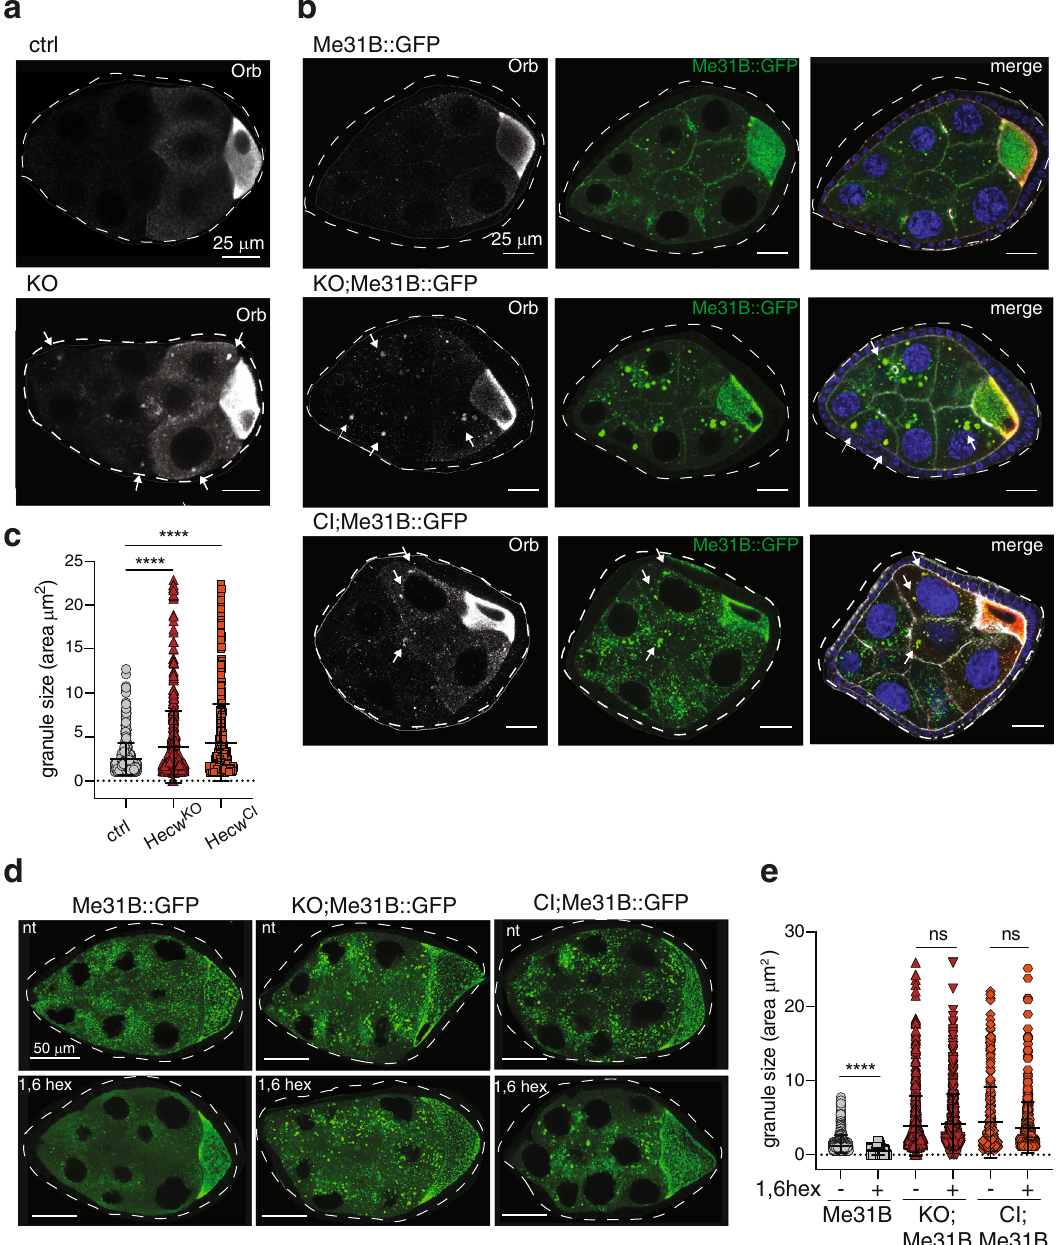
Fig. 4 RNP morphology and composition is altered in Hecw KO . a IF analysis of egg chambers from 3-day-old fl ies of the indicated genotypes with anti-Orb antibody ( n = 3). White arrows indicate ectopic Orb puncta in nurse cells of Hecw KO fl ies. b IF analysis of the indicated genotypes ( n = 3). Green, Me31B::GFP which marks the RNPs; red, Orb which marks the oocyte (in white in the fi rst panel); blue, DAPI; white, phalloidin. Scale bar: 25 μ m. c Quanti fi cation of RNPs size of egg chambers (stages from 6 – 9) from 3-day-old fl ies of the indicated genotypes. Results are expressed as mean ± SD. n = 477 (ctrl Me31B::GFP), n = 559 (Hecw KO ;;Me31B::GFP), n = 444 (Hecw CI ;;Me31B::GFP), 5 egg chambers/genotype from two biological replicates. **** P < 0,0001 by two-tailed Mann – Whitney test. d IF analysis of egg chambers of 3-day-old fl ies as indicated ( n = 3), not treated (nt) or treated with 1,6 hexanediol (1,6 hex). Scale bar: 50 μ m. e Quanti fi cation of RNPs size in egg chambers (stage 7 – 9) of the indicated genotypes and conditions. Treatment signi fi cantly reduces RNP size in control but not in Hecw KO and Hecw CI fl ies (KO;Me31B::GFP and CI;Me31B::GFP). Particles analysed: n = 505 ctrl (nt), n = 49 ctrl (1,6 hex), n = 642 Hecw KO (nt), n = 536 Hecw KO (1,6 hex), n = 314 Hecw CI (nt), n = 553 Hecw CI (1,6 hex) (3 egg chambers/genotype). Size mean ± SD is reported. **** P < 0.0001 by two-tailed Mann – Whitney test.